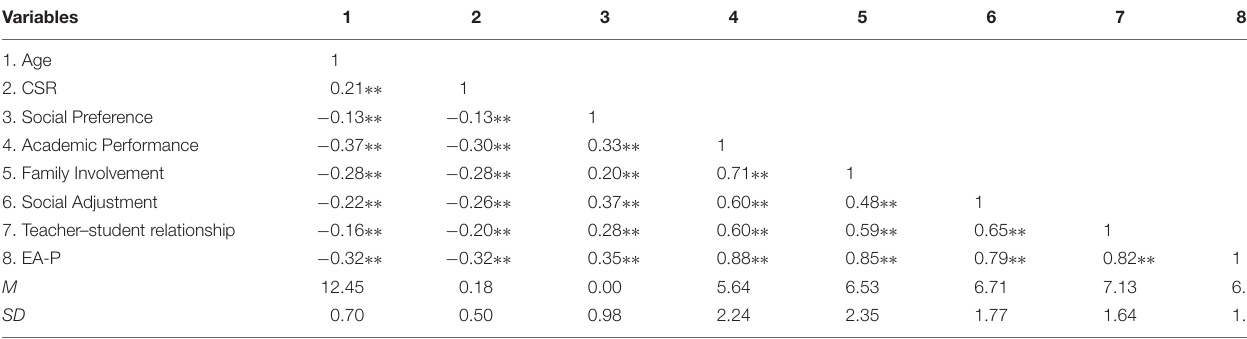
TABLE 1 | Descriptive statistics and bivariate correlations between target variables. Variables